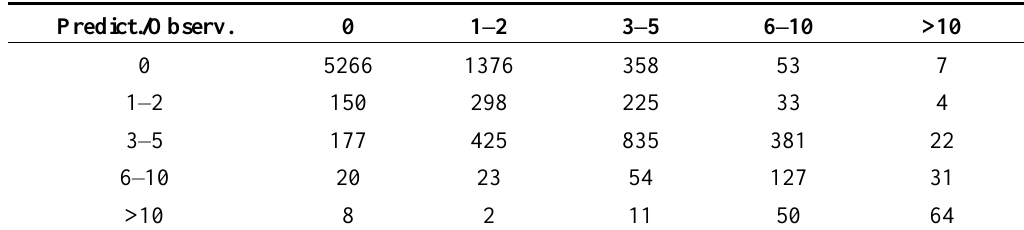
Table 2. Confusion matrix comparing predicted and observed number of policies for a 10,000 test dataset in Besiktas.